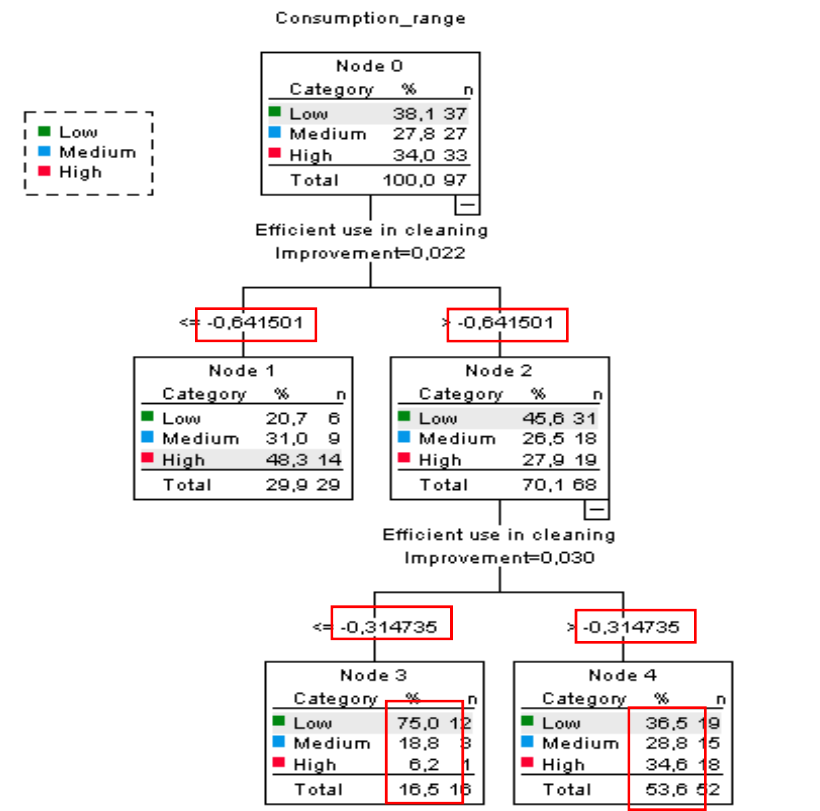
Figure 1. Summary tree of the Classification and Regression Trees (CART) algorithm on the joint influence of values/needs and attitudes to predict the range of household consumption. (Source: Authors).